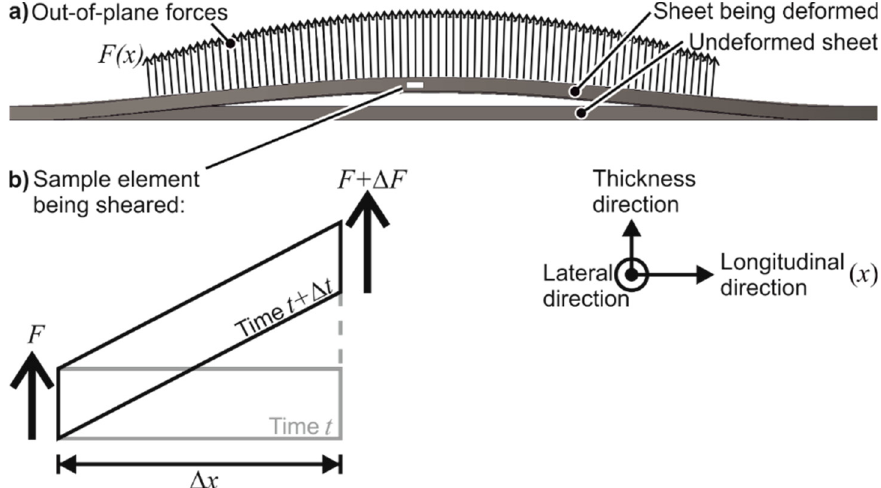
Figure 26. Out-of-plane volumetric forces can induce out-of-plane shear